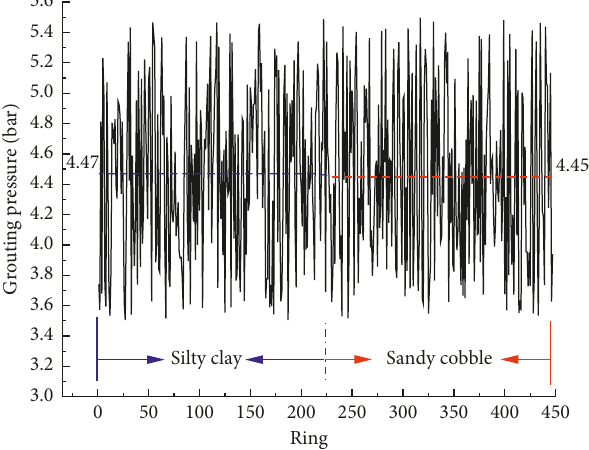
Figure 12: History of synchronous grouting